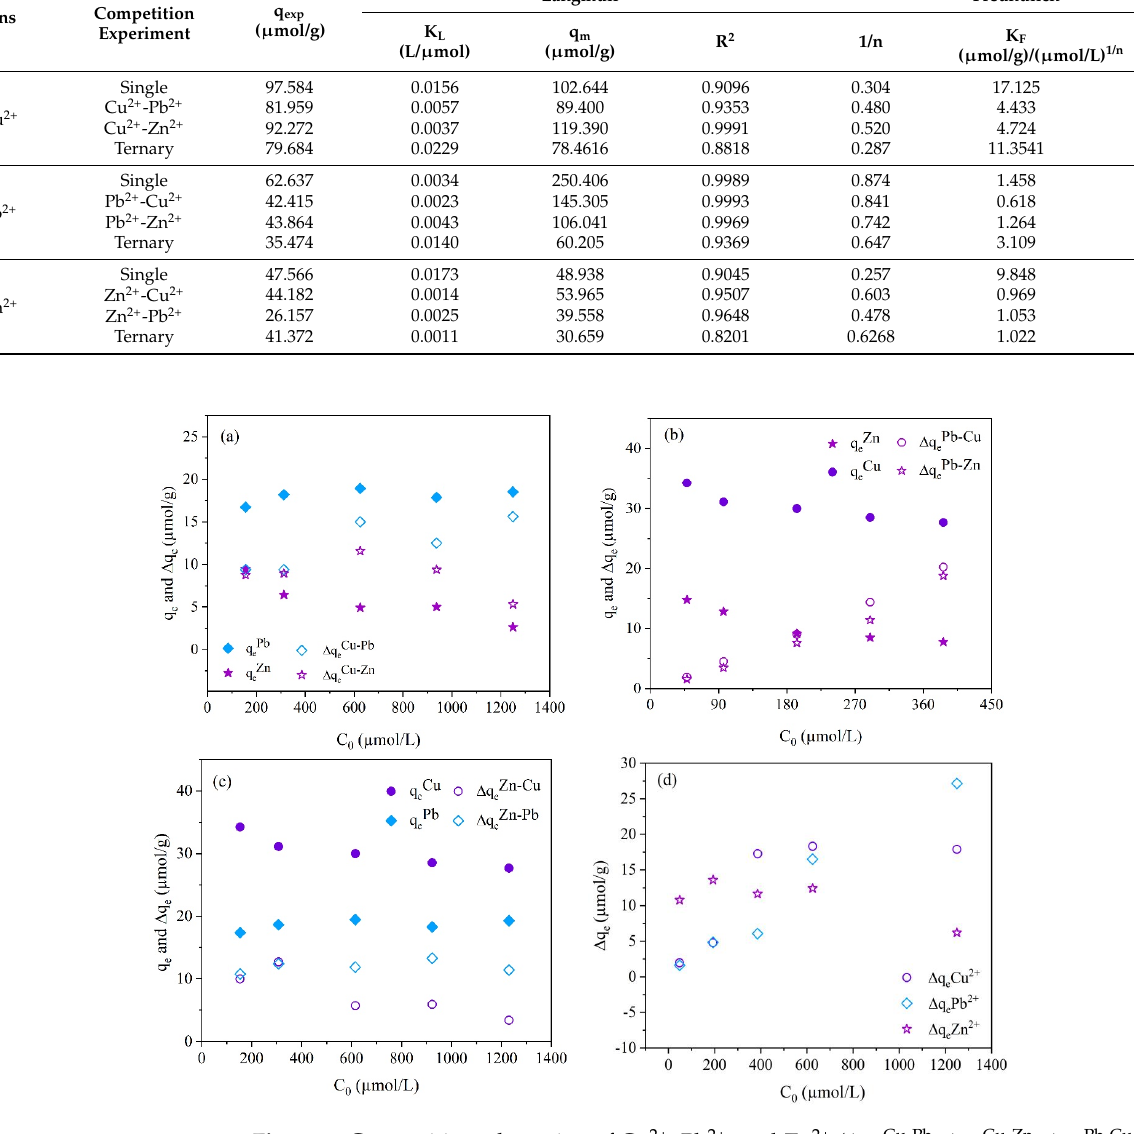
Figure 7. Competitive adsorption of Cu 2+ , Pb 2+ , and Zn 2+ (∆q eCu-Pb , ∆q eCu-Zn , ∆q ePb-Cu , ∆q ePb-Zn , ∆q eZn-Cu and ∆q eZn-Pb represent the absolute equilibrium adsorption capacity of Cu 2+ ( a ), Pb 2+ ( b ), and Zn 2+ ( c